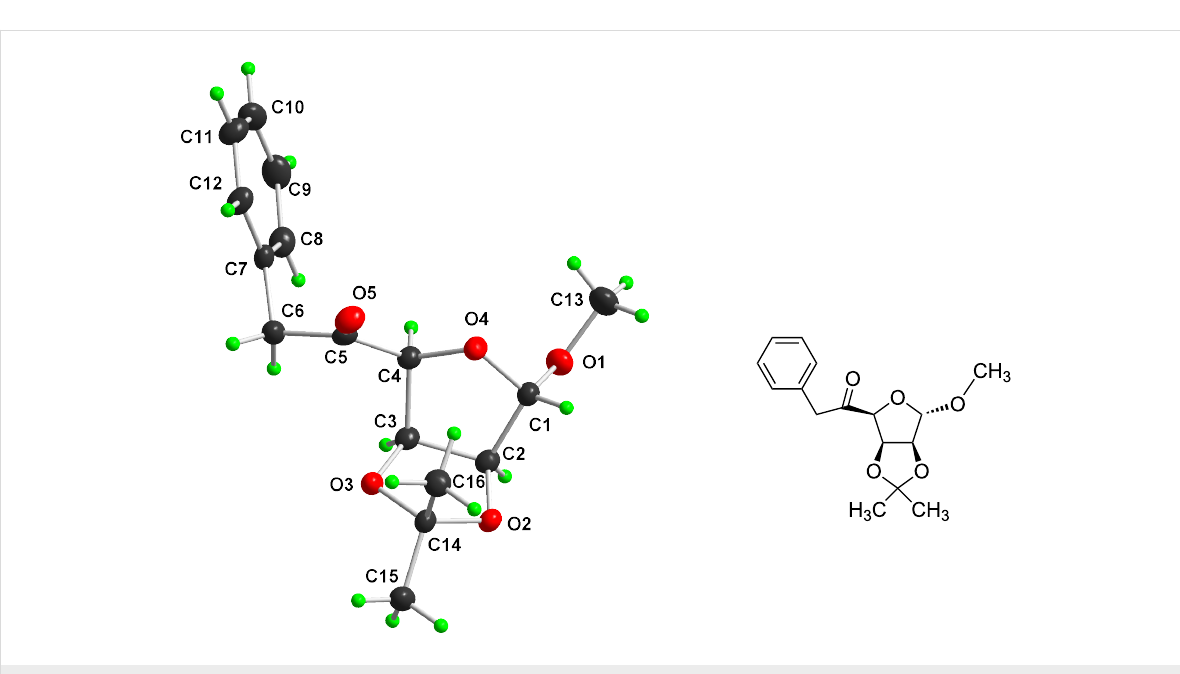
Scheme 2, path 2) and 1-methylnaphthalene ( 12 ). On the other hand, the reaction of 10 with ketones produced either normal benzylic alcohols, rearranged alcohols or a mixture of both, depending on the steric hindrance. However, the rearranged alcohols representing 1-methylene-2-substituted-1,2-dihydron- aphthalenes F (analogues of intermediate B in Scheme 2) were unstable and decomposed to 1-methylnaphthalene ( 12 ) and the